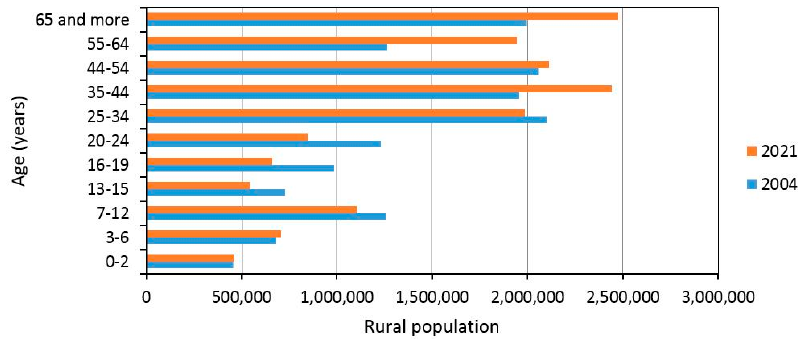
Figure 16. Rural population age distribution in 2004 and 2021, data obtained from [66].